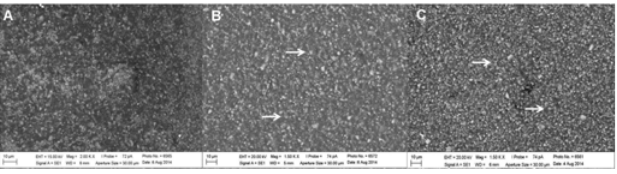
Fig. 2. SEM images of the surface morphology for the Fluroshield group (1500 X): (A) baseline; (B) after erosive challenge and (C) after saliva immersion; ( (cid:74) ): filler particles.